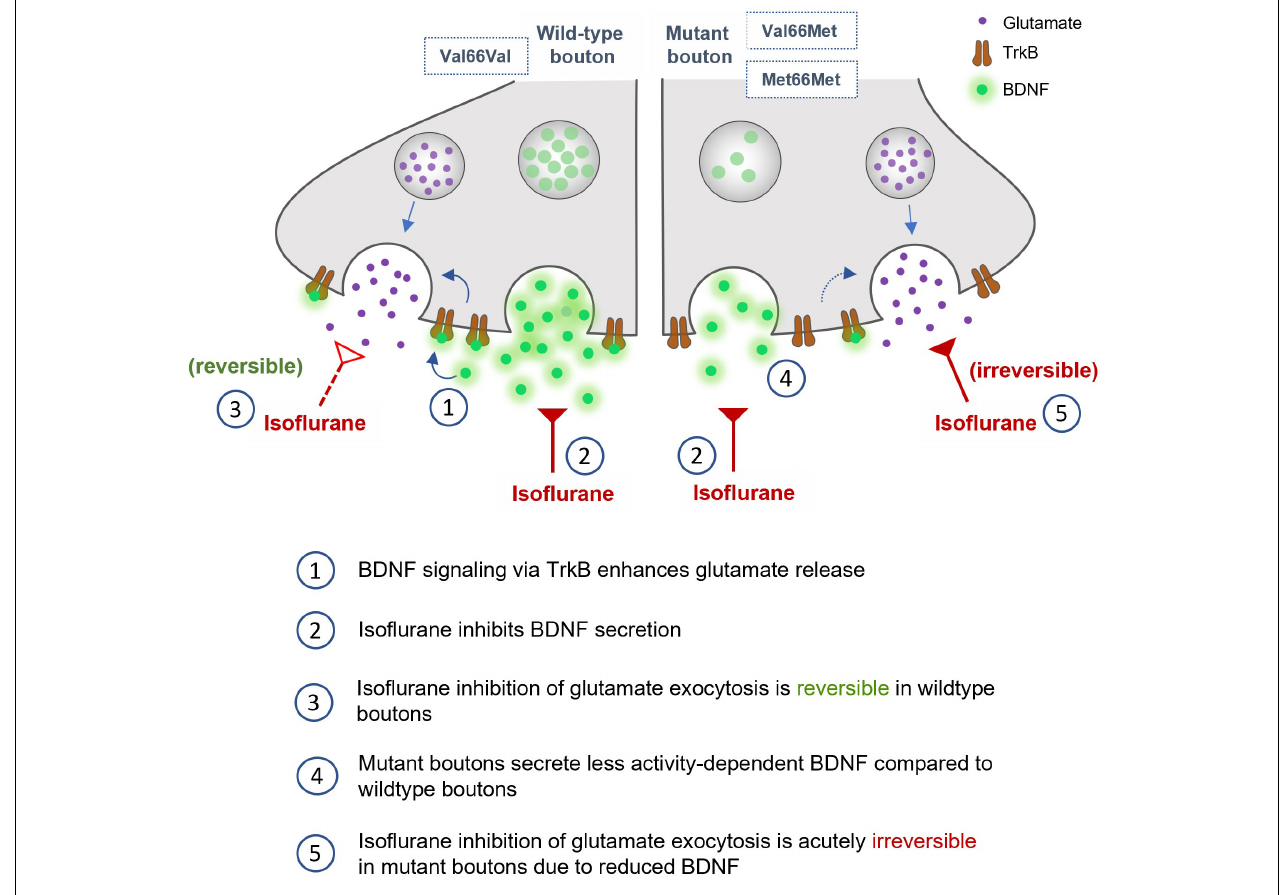
FIGURE 7 | Role of BDNF in isoflurane depression of synaptic transmission in wild-type, Val66Met, and Met66Met hippocampal